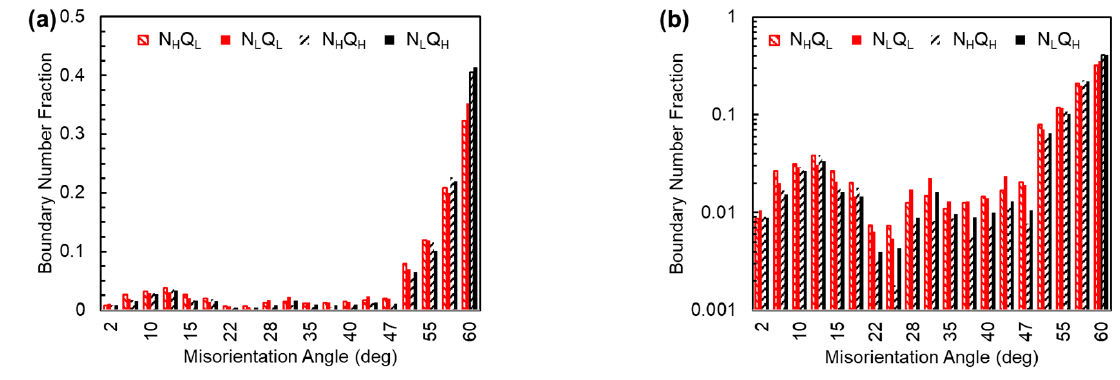
Figure 8. Distribution of misorientation angles of the quenched and tempered alloy using ( a ) linear and ( b ) log scale. Table 3. Sum of misorientations of the 15–45° angle and the 46–60° angles.